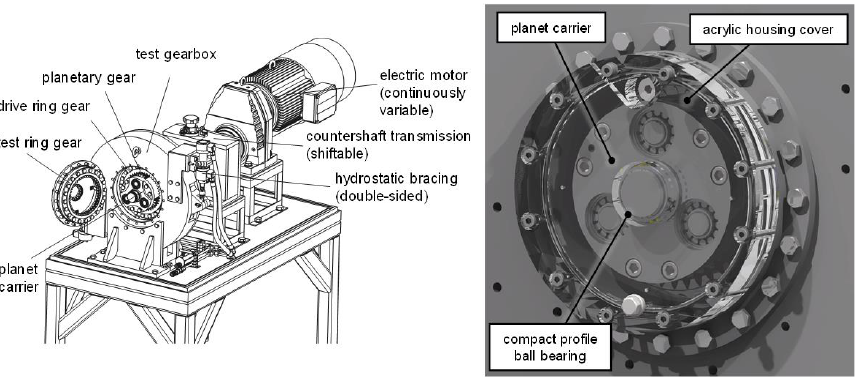
Figure 1. FZG internal gear test rig ( left ) and rendering of the modified FZG internal gear test rig with transparent housing cover ( right ) [25].